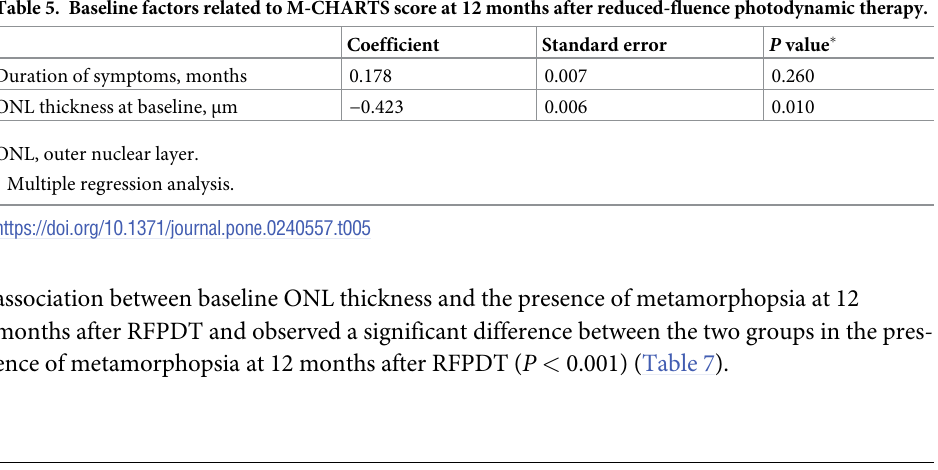
Table 4. Correlation between M-CHARTS score at 12 months after reduced-fluence photodynamic therapy and clinical parameters at the same time point. r P value � BCVA, logMAR − 0.011 0.948 CFT, μ m − 0.518 0.001 ONL thickness, μ m − 0.523 0.001 Increase in ONL thickness, μ m − 0.383 0.021 Presence of PED (+/ − ) − 0.035 0.838 Disrupted ELM layer (+/ − ) 0.000 1.000 Disruption of EZ layer (+/ − ) − 0.261 0.125 BCVA, best-corrected visual acuity; logMAR, logarithm of the minimum angle of resolution; CFT, central foveal thickness; ONL, outer nuclear layer; PED, pigment epithelial detachment; ELM, external limiting membrane; EZ, ellipsoid zone. � Spearman’s rank correlation coefficient.